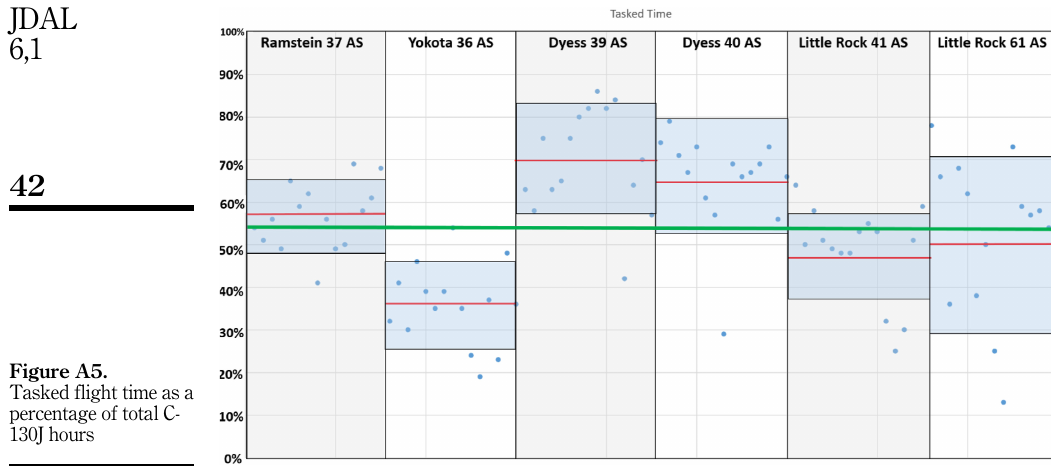
Figure A5. Tasked flight time as